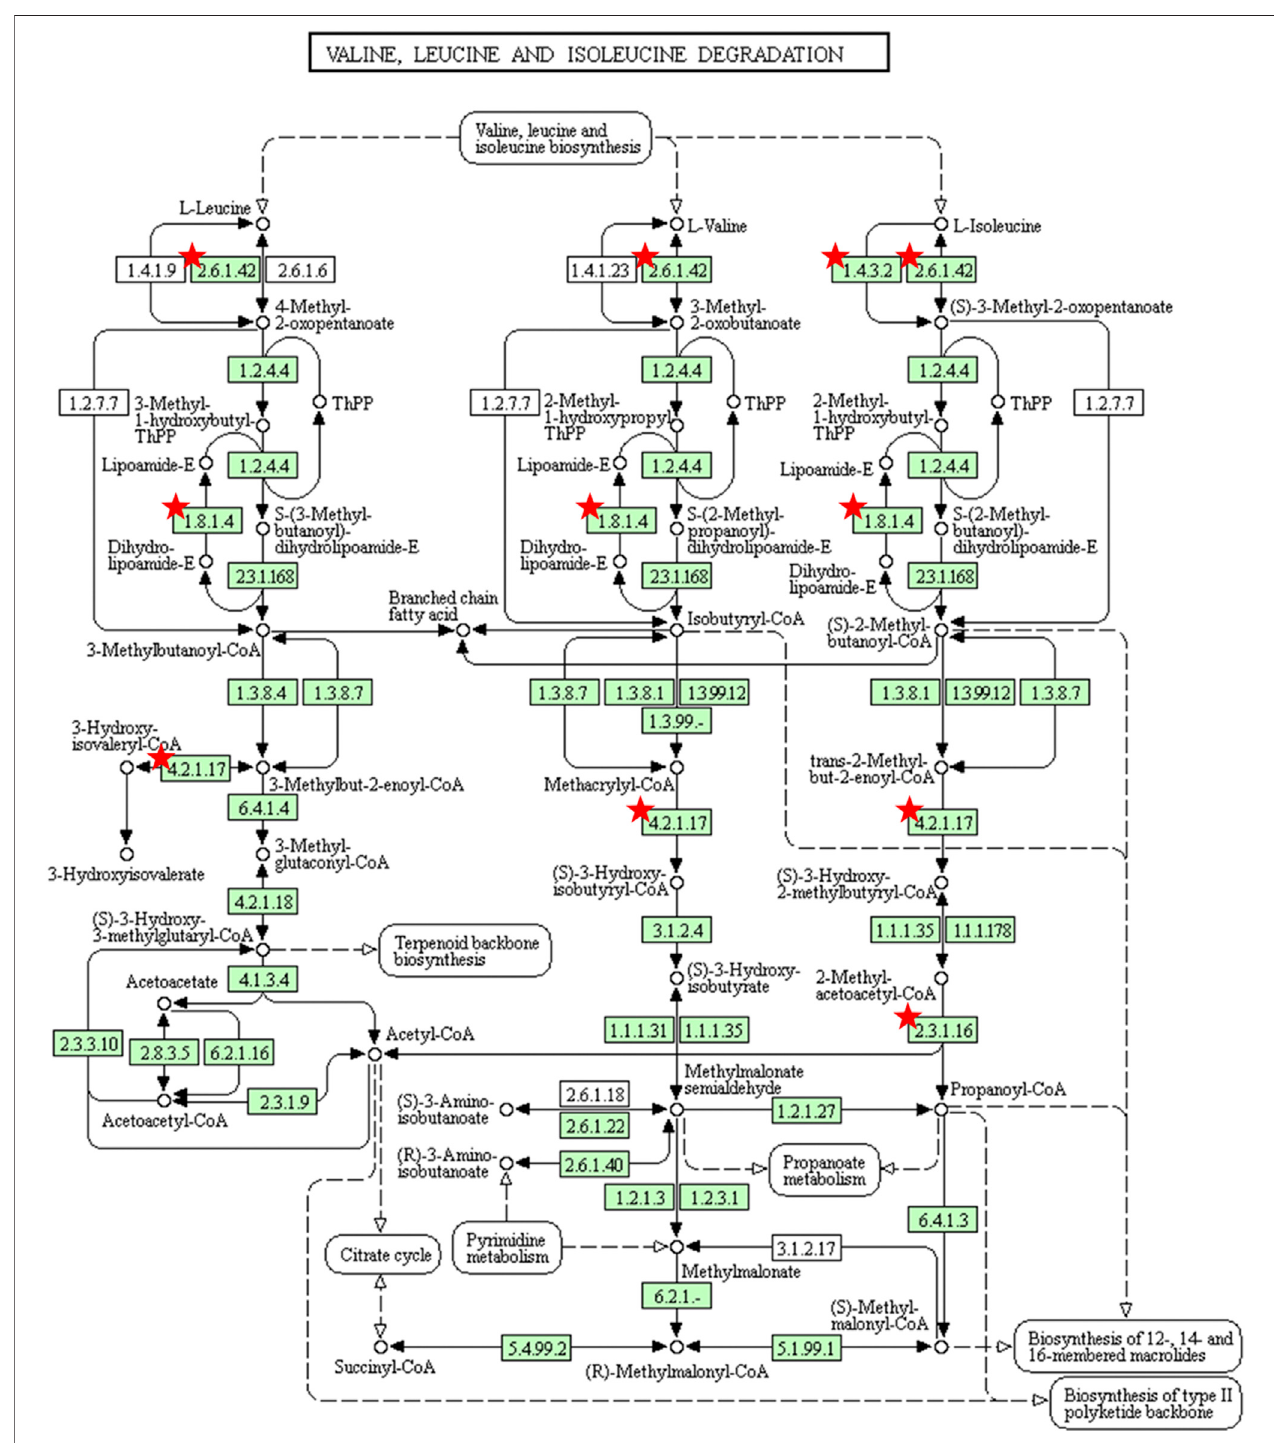
FIGURE 9 | Pathway of branched-chain amino acids catabolism found by KEGG Pathway maps. The organism-speci fi c pathways are colored green, where coloringindicatesthatmapobjectsexistandarelinkedtocorrespondingentries.TheredstarsmarkpotentialtargetsofLBGinpathways.ItisindicatedthatLvjiaobuxue granule attenuates cyclophosphamide-induced leukopenia by regulating branched-chain amino acids catabolism pathway.